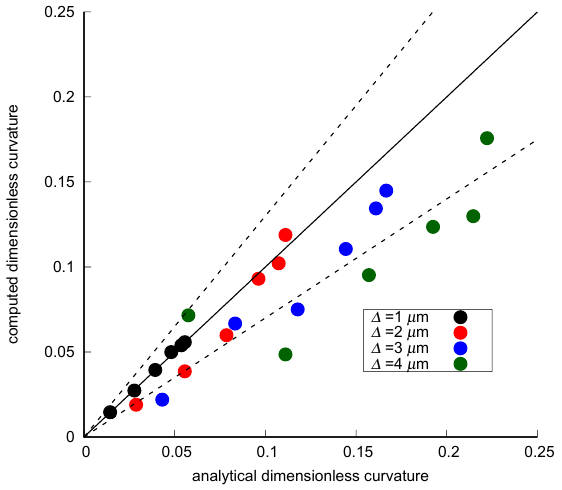
Figure 10. Comparison between analytical and computed dimensionless curvature ( κ ∗ ) for the 24 surfaces. ± 30% error is indicated by the dotted